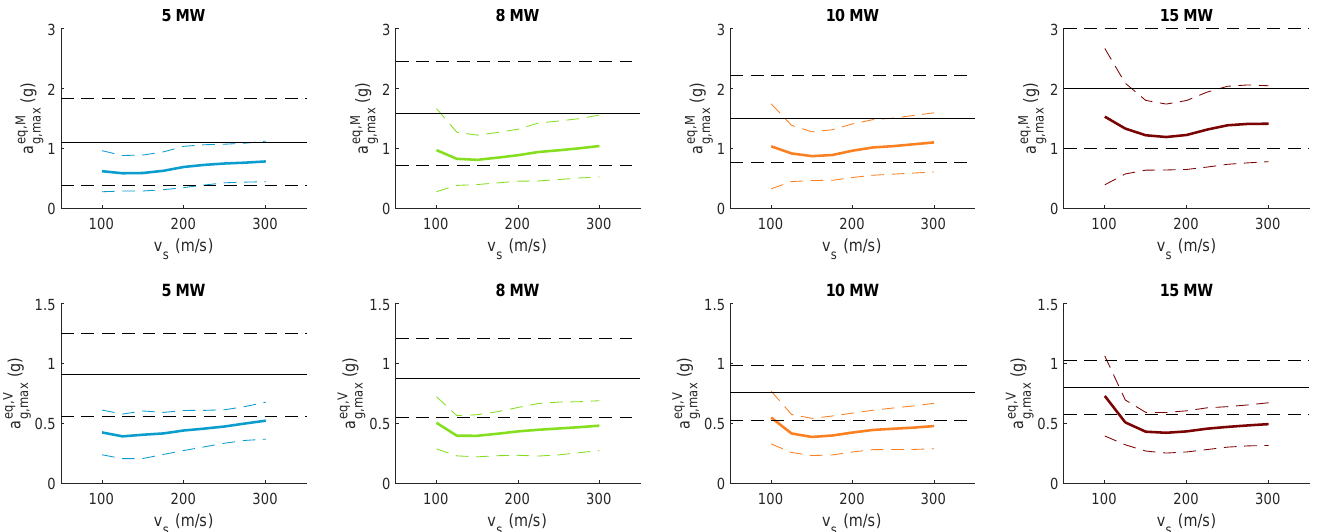
Figure 6. Equivalent ground maximum acceleration for the bending moment and shear force at the mudline level. Mean value (solid line) and dispersion (dashed lines) of the results corresponding to different accelerograms. Results including SSI effects (color) and under rigid base